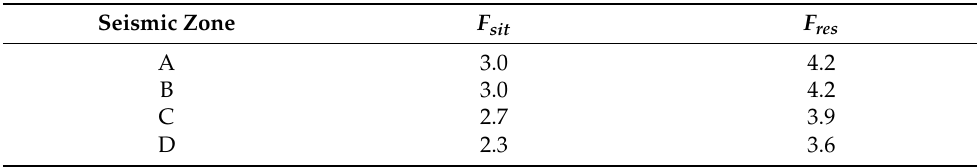
Table 4. Site and response factors for the B2 subgroup structures, reproduced with permission